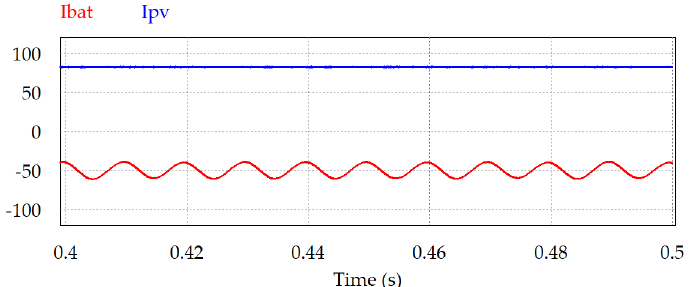
Figure 18. Simulation results of operation mode 1, PV input current I PV —battery charging cur- rent I bat .